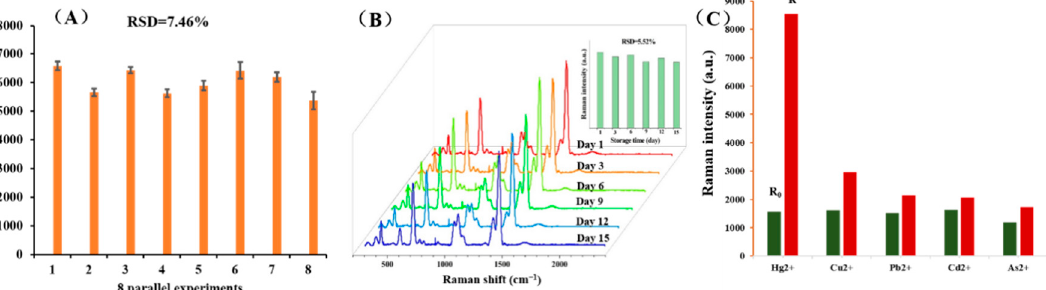
Figure 6. Reproducibility and stability experiments. ( A ) SERS spectra in eight parallel